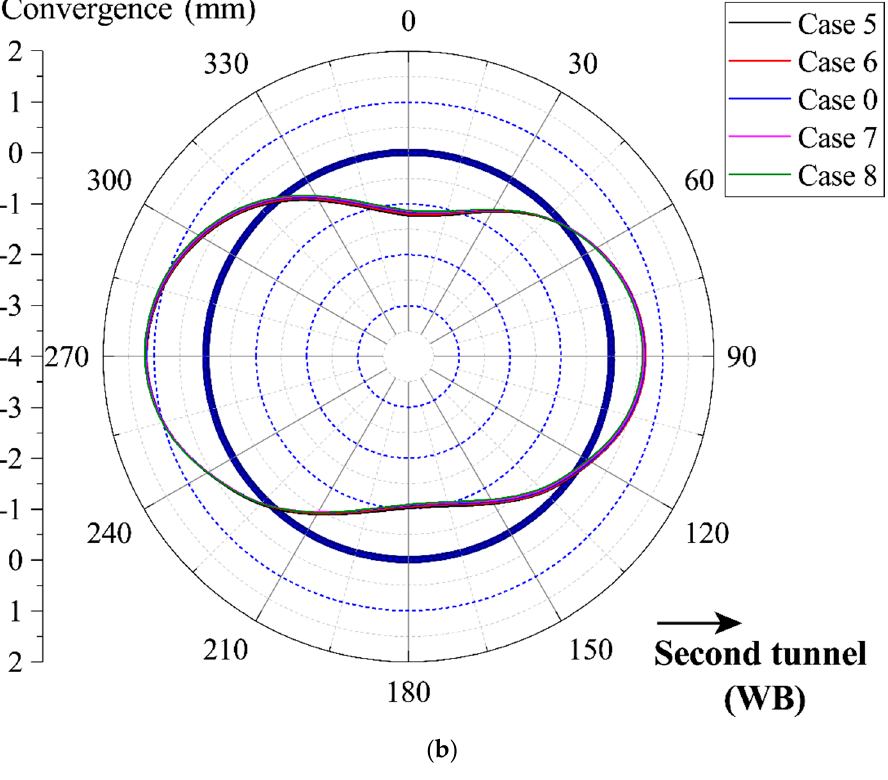
Figure 12. Convergence of ER60 in different cases: ( a ) influence of grouting pressure on ER60 convergence; ( b ) influence of face supporting pressure on ER60 convergence.